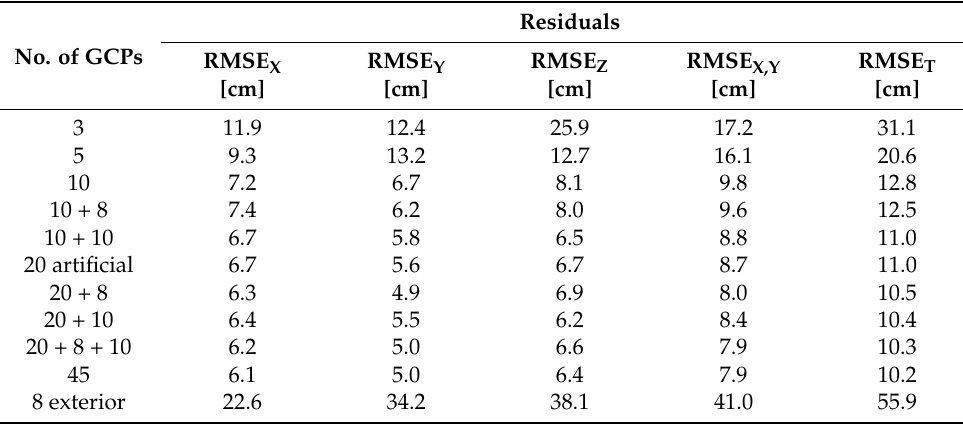
Table 1. The residuals of 275 ChPs for 11